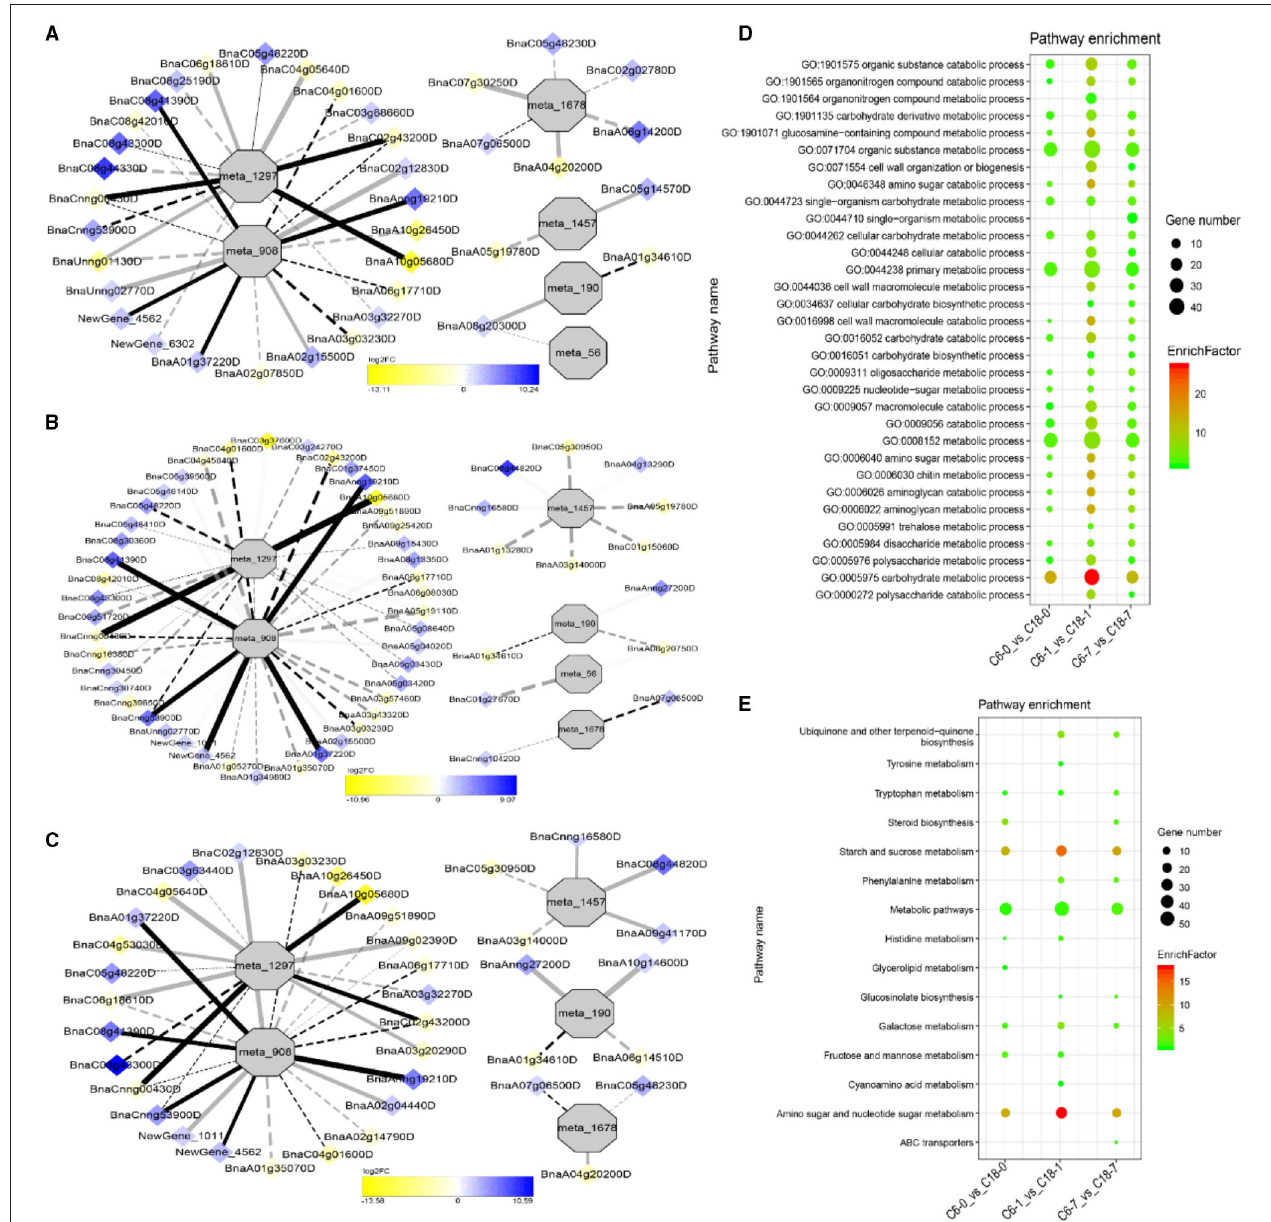
FIGURE 5 | Correlation network analysis between DAMs and regulatory genes related to cold stress (CS). (A) Analysis of C6-0 vs. C18-0, (B) analysis of C6-1 vs. C18-1, and (C) analysis of C6-7 vs. C18-7. Log 2 FC of genes, in response to CS, are indicated in heatmap colors ranging from yellow (downregulated) to blue (upregulated); log 2 FC values are indicated in the legend; the width of the connecting lines indicating the strength of the correlation; solid lines indicating the positive correlation and dashed lines indicating the negative correlation; black lines indicating the common genes and gray lines indicating the specific genes accumulated at that time point. (D,E) Scatter plots for the gene ontology-biological process (GO-BP) enrichment analysis and the Kyoto Encyclopedia of Genes and Genomes (KEGG) pathway enrichment analysis of DEGs from G1, respectively. Only the highly enriched and most relevant terms and pathways are shown in the plots ( Q < 0.05.) –log 10 ( Q ) for enrichment